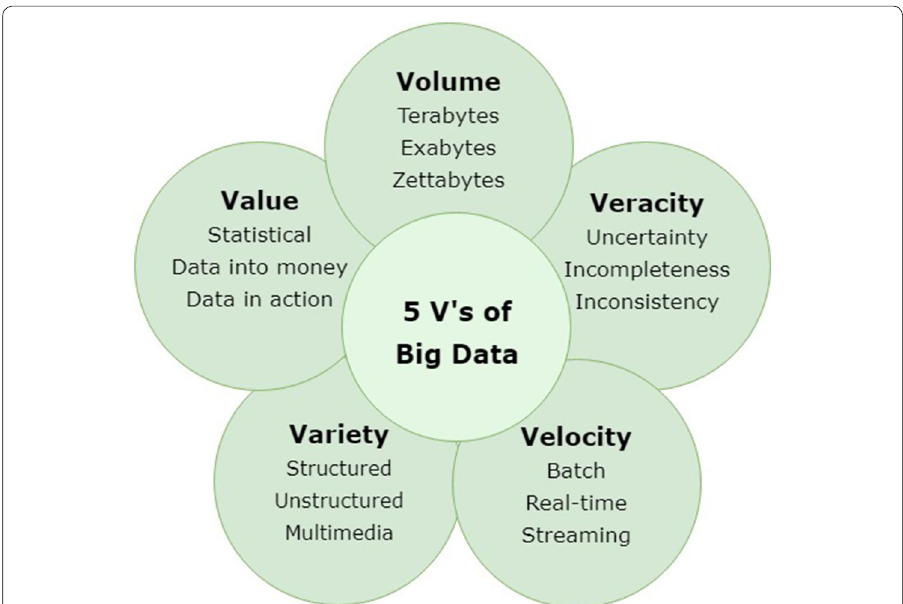
Fig. 1 Common big data